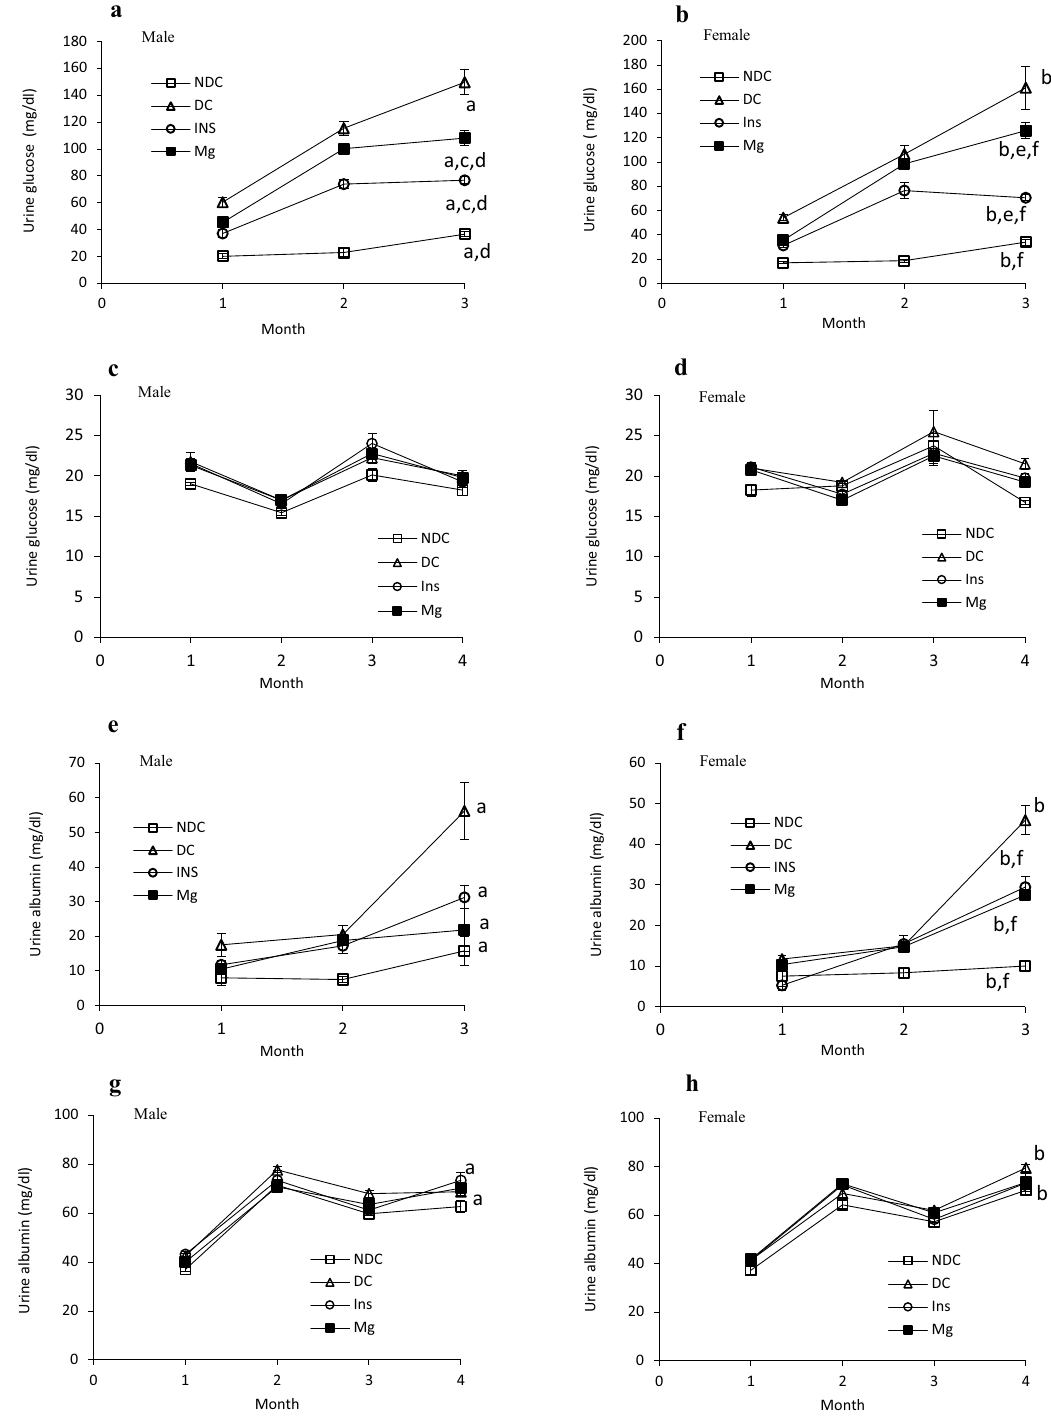
Figure 5. Comparison of urine glucose in male and female parents and their male and female offspring ( a , b , c and d respectively) and urine albumin in male and female parents and their male and female offspring ( e , f , g and h respectively) and urine urea in male and female parents and their male and female offspring ( i , j , k and l respectively) in non-diabetic control group (NDC) was fed with normal diet , diabetic group received high-fat diet and 35 mg/ Kg STZ (D), diabetic animals treated with insulin (2.5 U/Kg two time per day) (Ins) and diabetic animals treated with 10 g/l magnesium sulfate via drinking water (Mg). 10 rats in each group and data are expressed as mean ± SEM. ( a ) Significant difference between D male group and other male groups ( P < 0.0001). ( b ) Significant difference between D female group and other female group ( P < 0.001). ( c ) Significant difference between male Mg group and male insulin group ( P < 0.001). ( d ) Significant difference between male NDC and male Mg and male insulin groups ( P < 0.001). ( e ) Significant difference between female Mg group and female insulin group ( P < 0.001). ( f ) Significant difference between female NDC and female Mg and female insulin groups ( P <